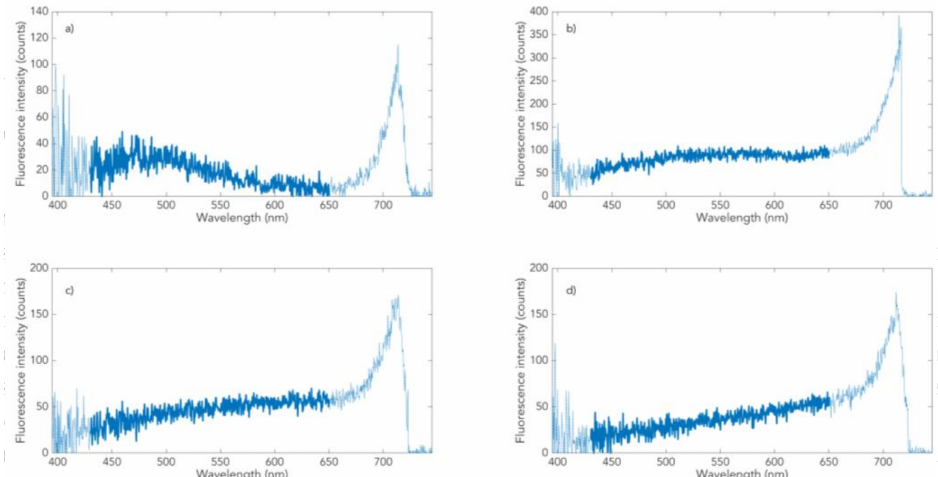
Figure 3. Dermatofluoroscopy of skin from Caucasian patients (Fitzpatrick type 2, 3) in vivo. The four representative classes of melanin-dominated spectra: ( a ) normal pigmented skin (class 4), ( b ) benign nevus (class 3), ( c ) dysplastic nevus (class 2), and ( d ) melanoma (class 1).